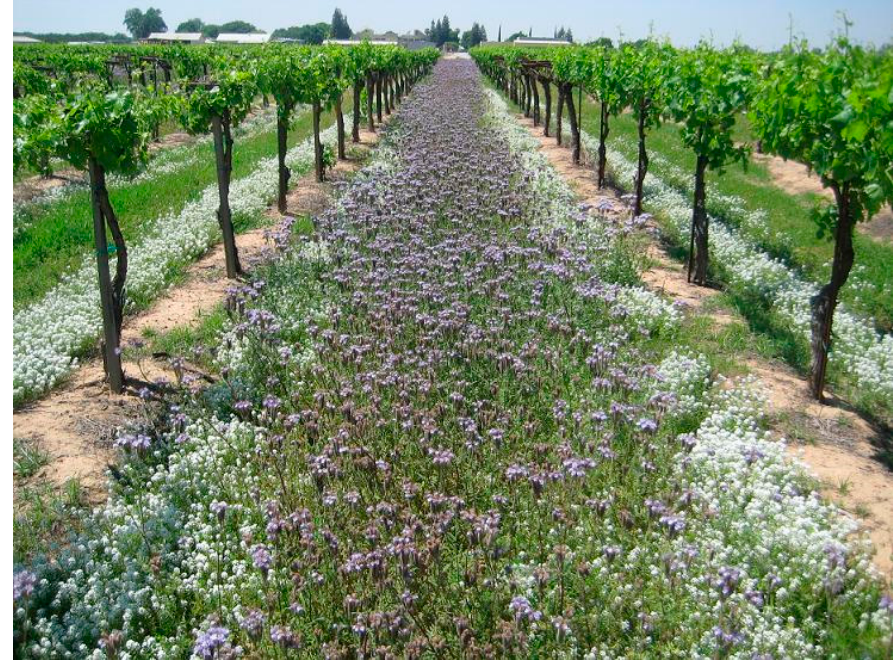
Figure 1. Summer flowering cover crops Phacelia tanacetifolia and Lobularia maritima in a vineyard.